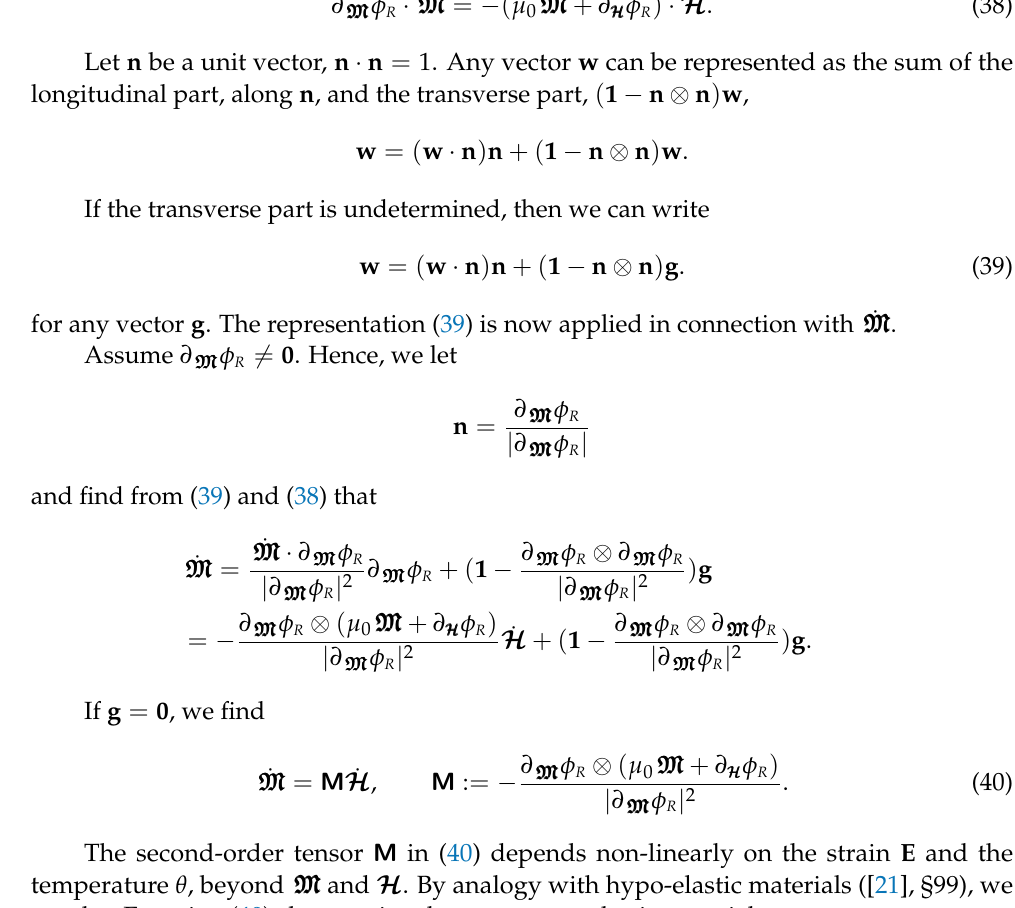
. Figure 2. Plot of the (Landau) differential magnetic susceptibility χ d with C = d